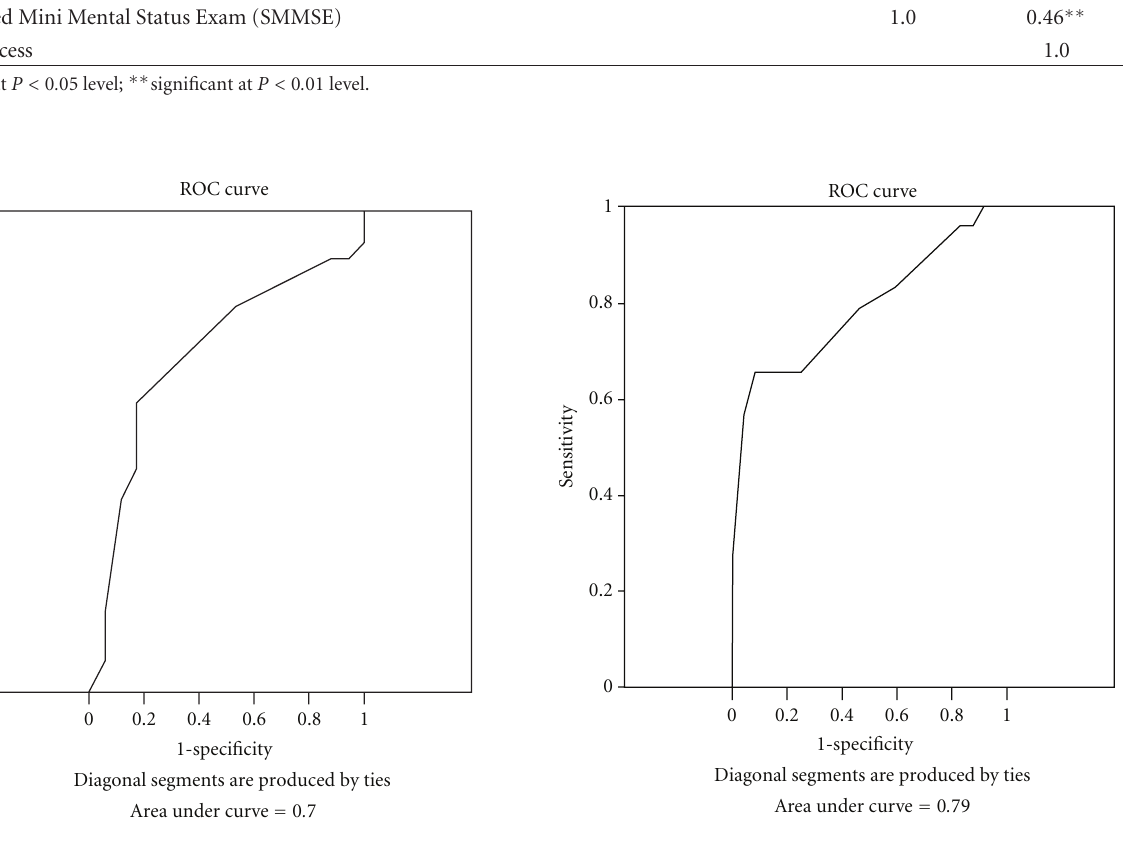
Figure 1: ROC curve for CPT with SMMSE as criterion. Figure 2: ROC curve for CPT with AMPS-Process as